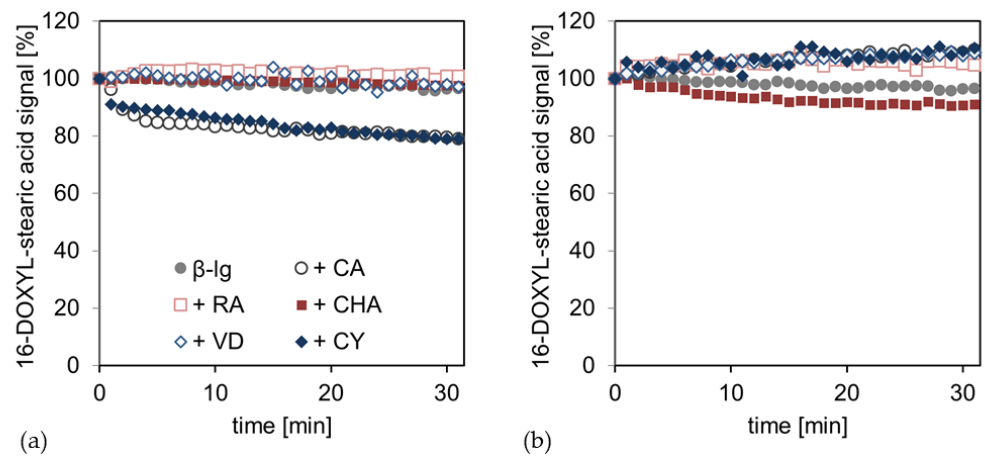
Figure 3. 16-DOXYL-stearic acid degradation kinetic from the lipid phase ( a ) of the emulsion at pH 6 and ( b ) at pH 9; Here, the β -Lg emulsions are compared without ( β -lg) and with PCD (+PCD) addition. The starting point at t = 0 min represents the output signal of the pure radical. From t = 1 min onwards, the radical degradation or radical regeneration is shown by an increase or decrease in the original radical signal.